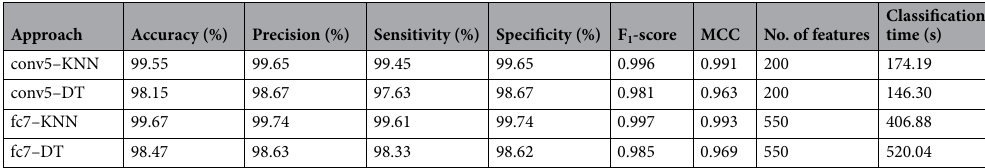
Table 7. Performance of the hybrid approach using the ReliefF feature selection technique.